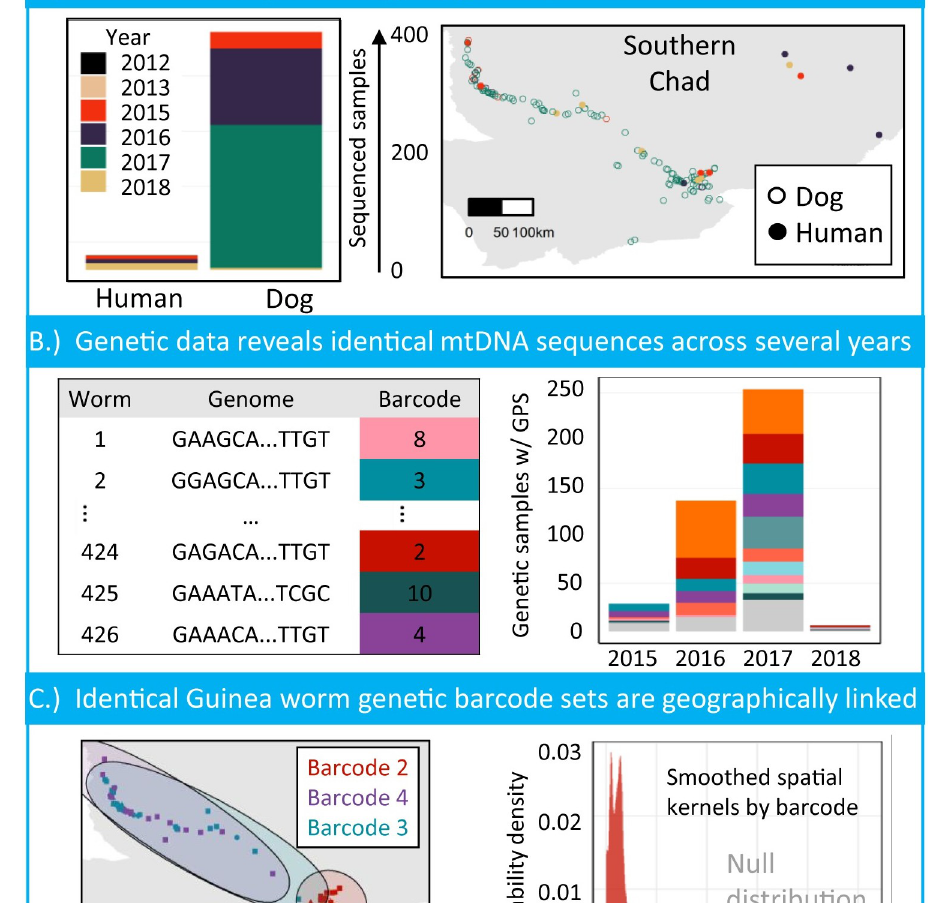
0.10 Genetically identical barcodes are geographically clustered 0.10.1 Population level comparisons. Genetically identical barcodes were spatially clus- tered in Chad. Identical barcodes were within a median 18.6 kilometer range (standard devia- tion = 82.5 kilometers), and often within an approximately 50 kilometer radius (Fig 2A).